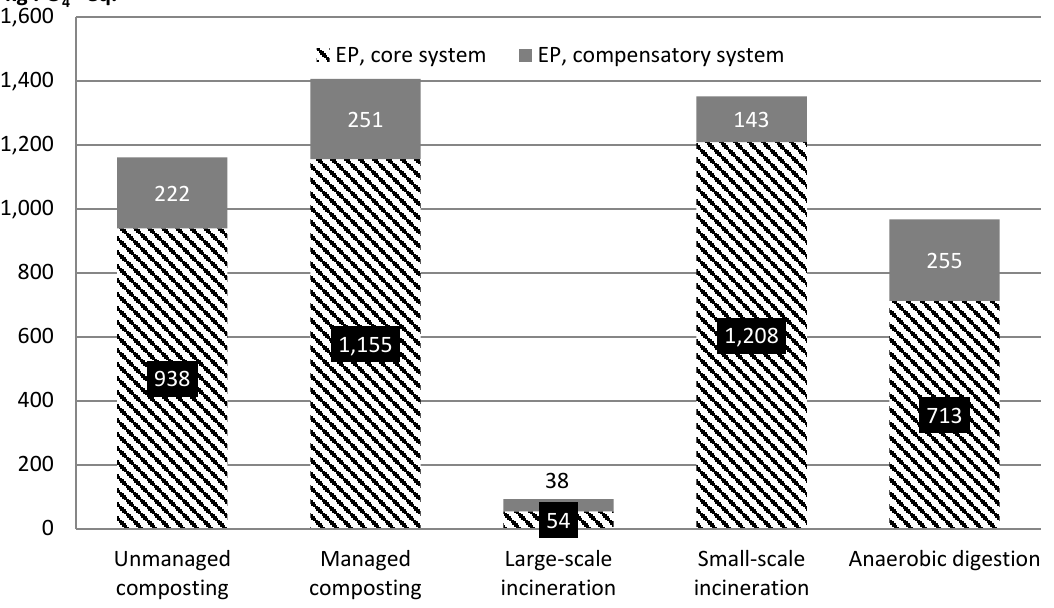
Figure 5. Eutrophication Potential (EP) in simulated scenarios.